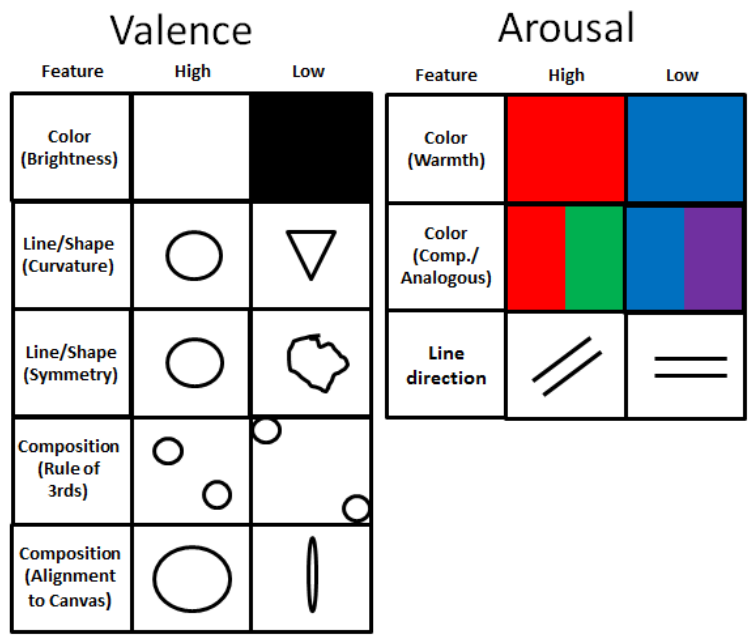
Figure 5. Heuristics for conveying basic emotions through abstract painting.